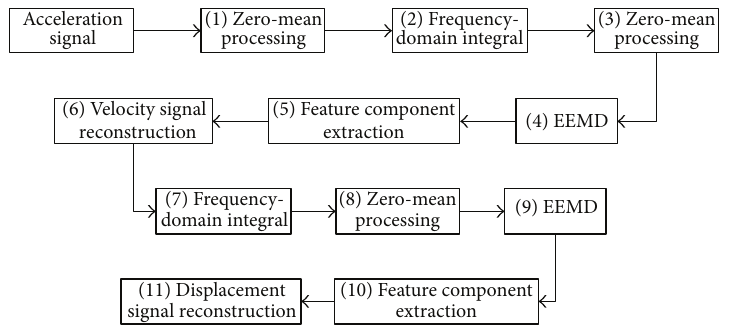
Figure 1: Process of the FIE-based integral